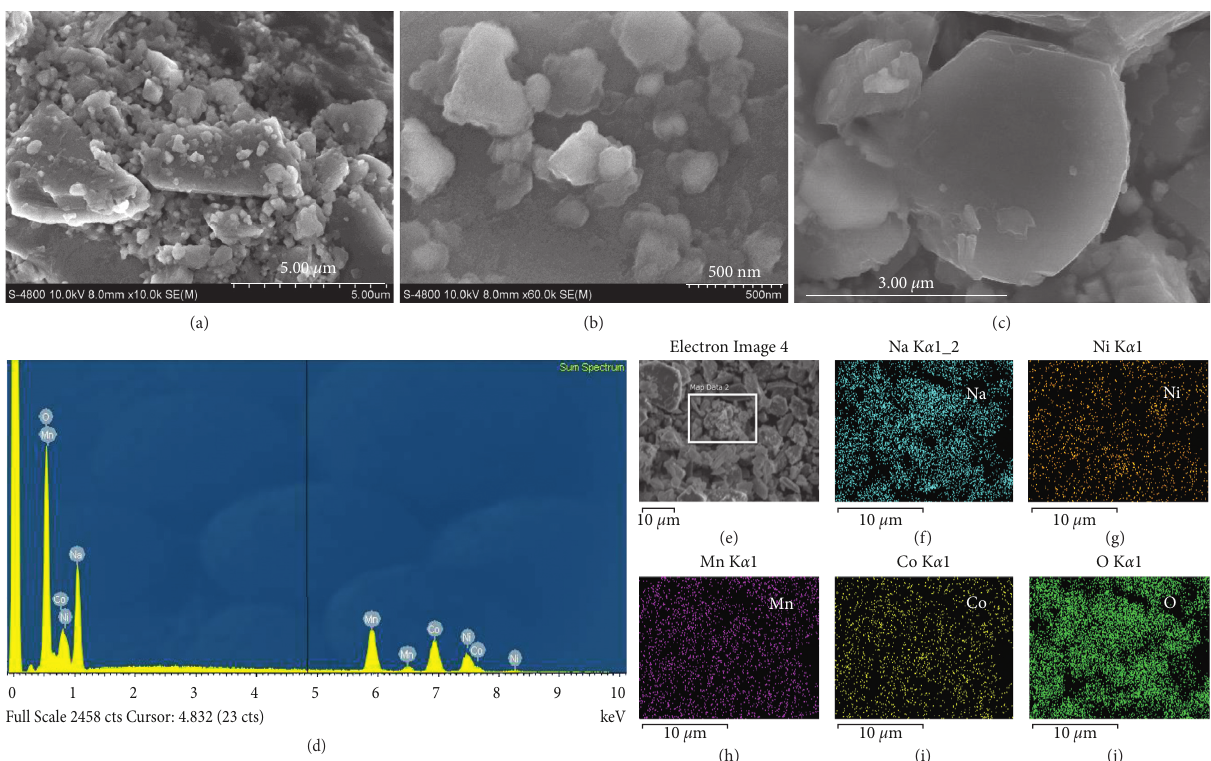
Figure 2: (a–c) SEM images of the sample and (d–j) the EDX spectrum showing the composition of various elements in the NaNMC